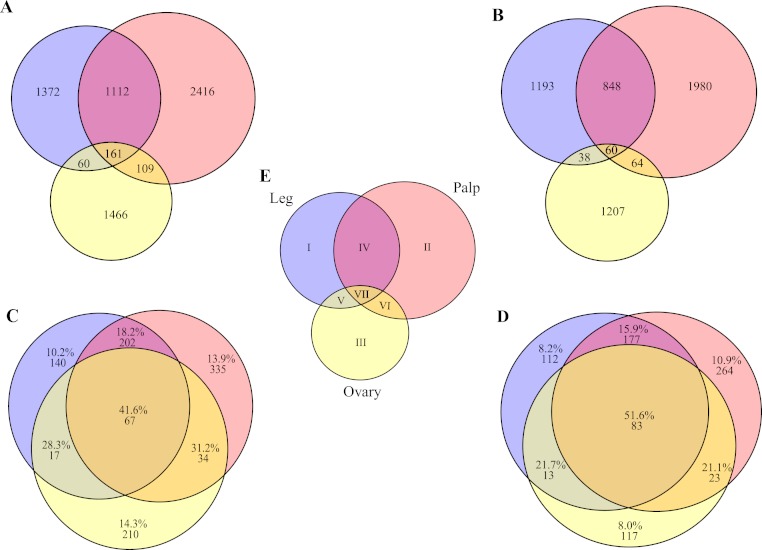
Transcript distribution across tissues.Venn diagrams showing the number of sequences expressed specifically in each tissue or in their intersections (blue, ochre and yellow indicate leg, palp and ovary, respectively). (A) All transcripts (n = 6,696). (B) Transcripts excluding putative housekeeping or CEG genes (n = 5,390). (C) Number and percentage of transcripts encoded by housekeeping genes (n = 1,005). (D) Number and percentage of transcripts with homologs included in the CEG database (n = 789). The area of each Venn diagram section is approximately proportional to the number of transcripts (A and B), or to the particular fraction value (C and D). (E) Roman numerals used to designate the different sections.